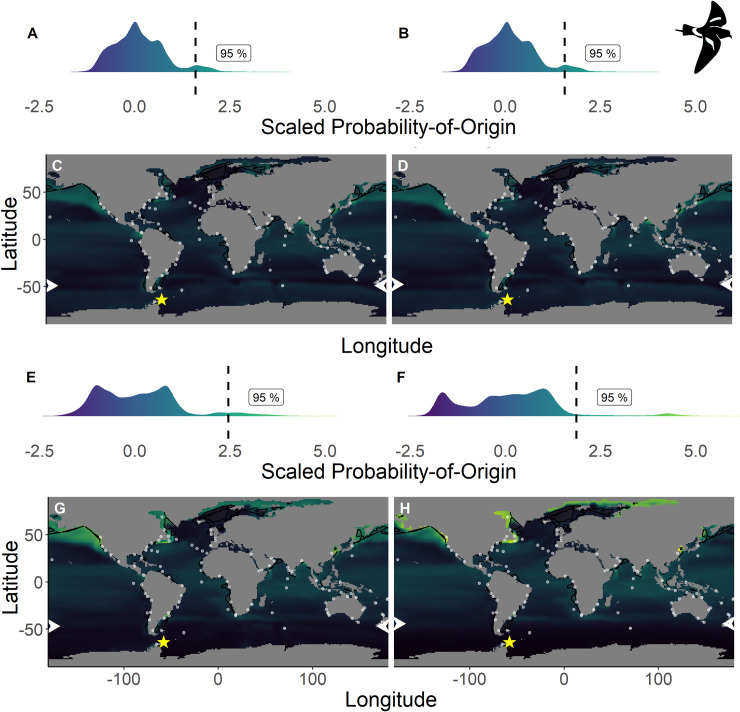
Scaled probability-of-origin maps based on δ13C and δ18O for each group for the Wilson’s storm-petrel.Terminal nodes from a conditional inference tree (CIT) based on differences between years, and correlated to body morphology (Fig 1B) were treated as groups. (A) Scaled probability-of-origin value distribution for terminal CIT node 5; (B) scaled probability-of-origin value distribution for terminal CIT node 6; (C) scaled probability-of-origin map for terminal CIT node 5; (D) scaled probability-of-origin map for terminal CIT node 6; (E) scaled probability-of-origin value distribution for terminal CIT node 8; (F) scaled probability-of-origin value distribution for terminal CIT node 9; (G) scaled probability-of-origin map for terminal CIT node 8; (H) scaled probability-of-origin map for terminal CIT node 9. Scaled probability-of-origin values are shown on a relative high (yellow)–low (black) gradient in both the density plots and maps. The 95% quantile of the scaled probability-of-origin values per terminal CIT node are shown with the dashed line. Shaded contours show high chlorophyll-a concentration areas (upper 95% of the data), and white dots show observation locations [88, 89]. The white arrows at the edge of the plot show the predicted moulting latitude based on the equation from Quillfeldt et al. 2005([76]; Table 4). The yellow star indicates the location of the breeding colony where birds were sampled.